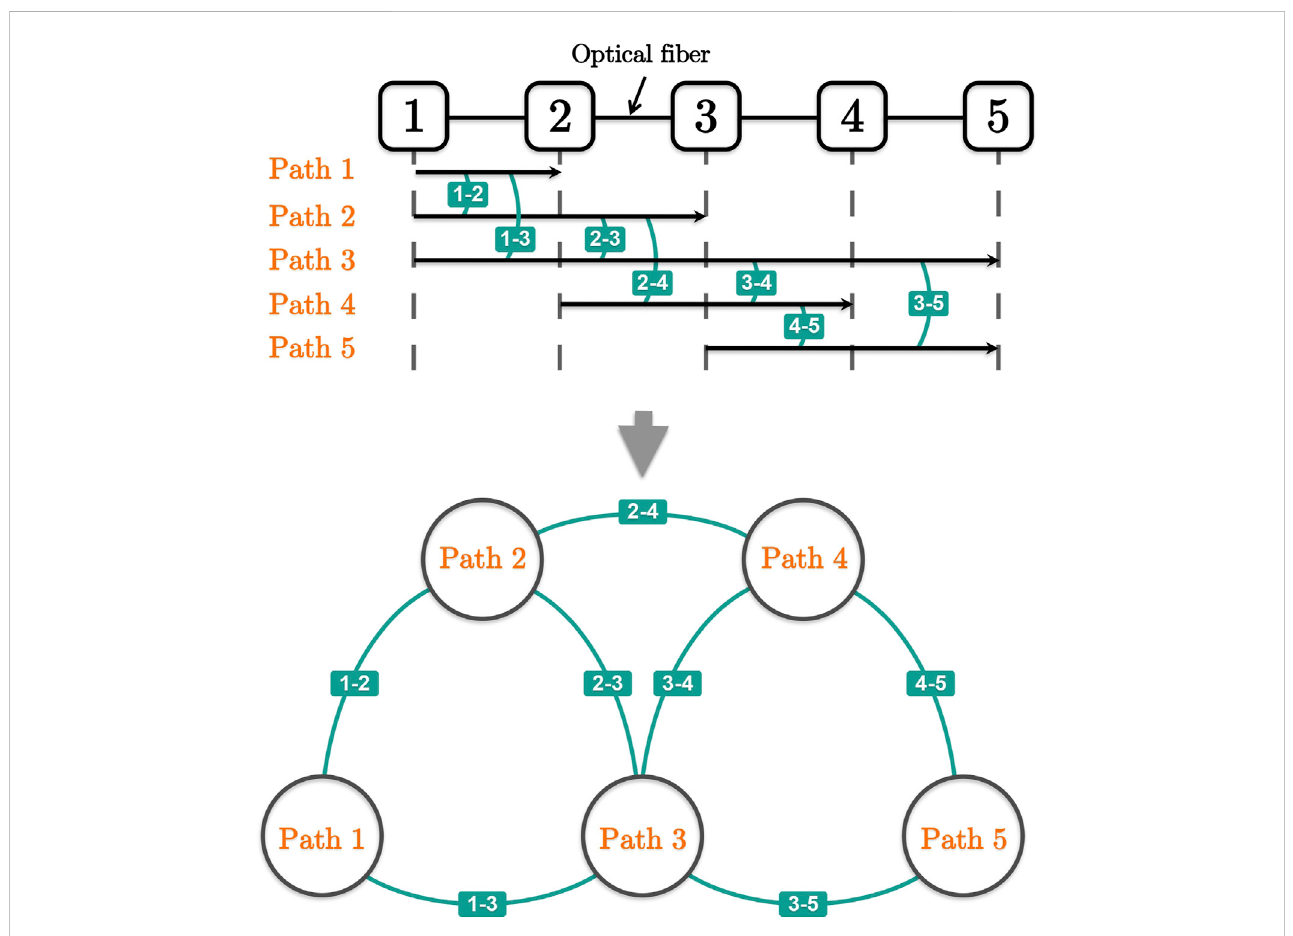
FIGURE 1 Illustration of the approach. A linear network with generated requests and paths consisting of fi ve nodes, four edges, and fi ve traf fi c paths is considered: Solid lines represent original edges, and the arrows represent traf fi c paths. One can reduce the WA problem to a graph coloring problem with a simple graph transformation(bottomofthe fi gure):eachtraf fi cpathisnowconsideredavertex;iftwotraf fi cpathsshare(atleast)one fi